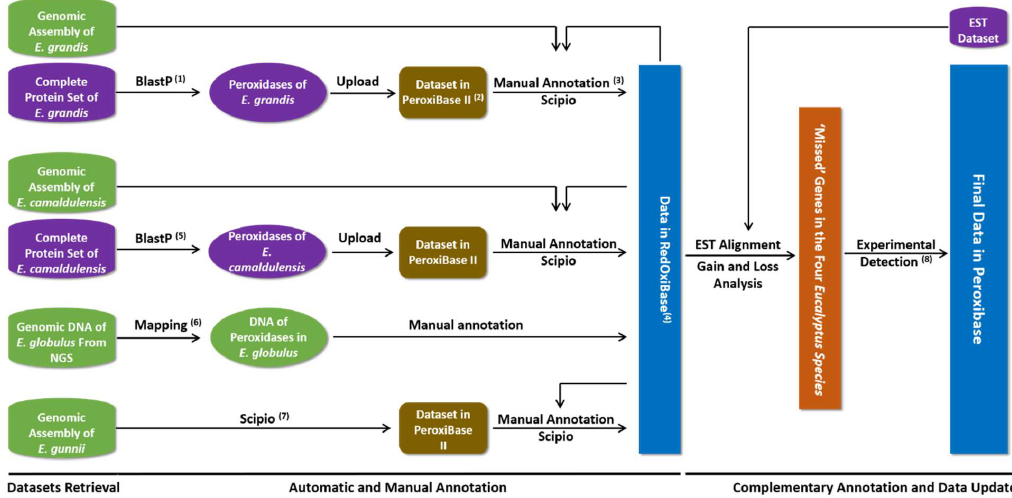
Figure 1. Workflow of the comprehensive annotation process of Eucalyptus ROS genes in